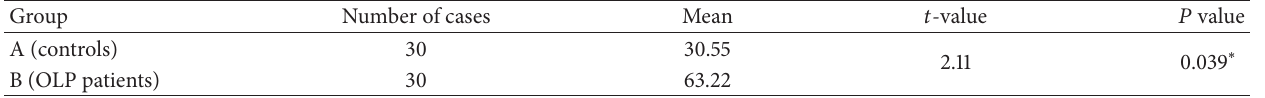
Table 1: Comparison of mean values of TNF- 𝛼 in saliva of Group A and Group B.